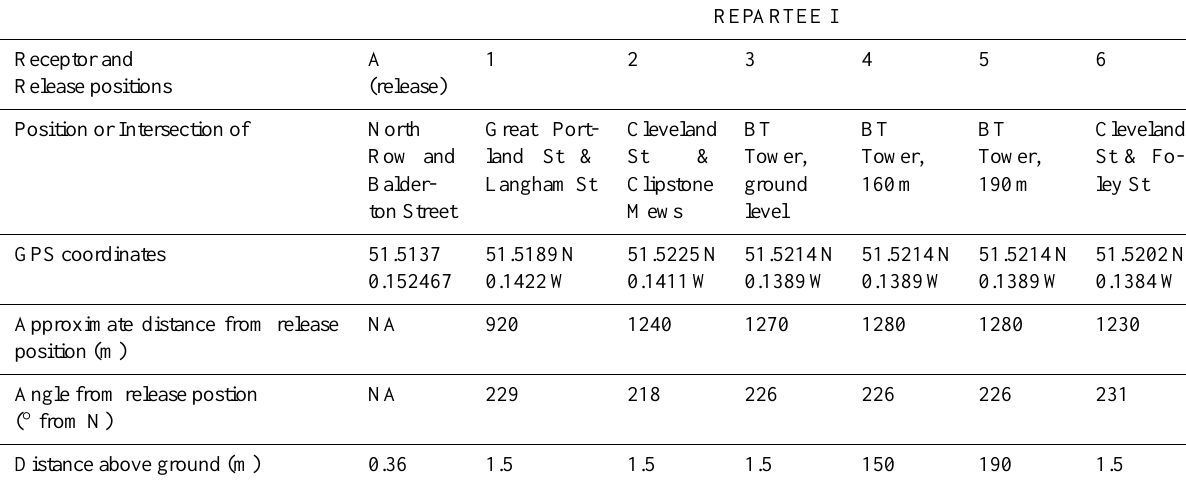
Table 1a. Experimental details for REPARTEE